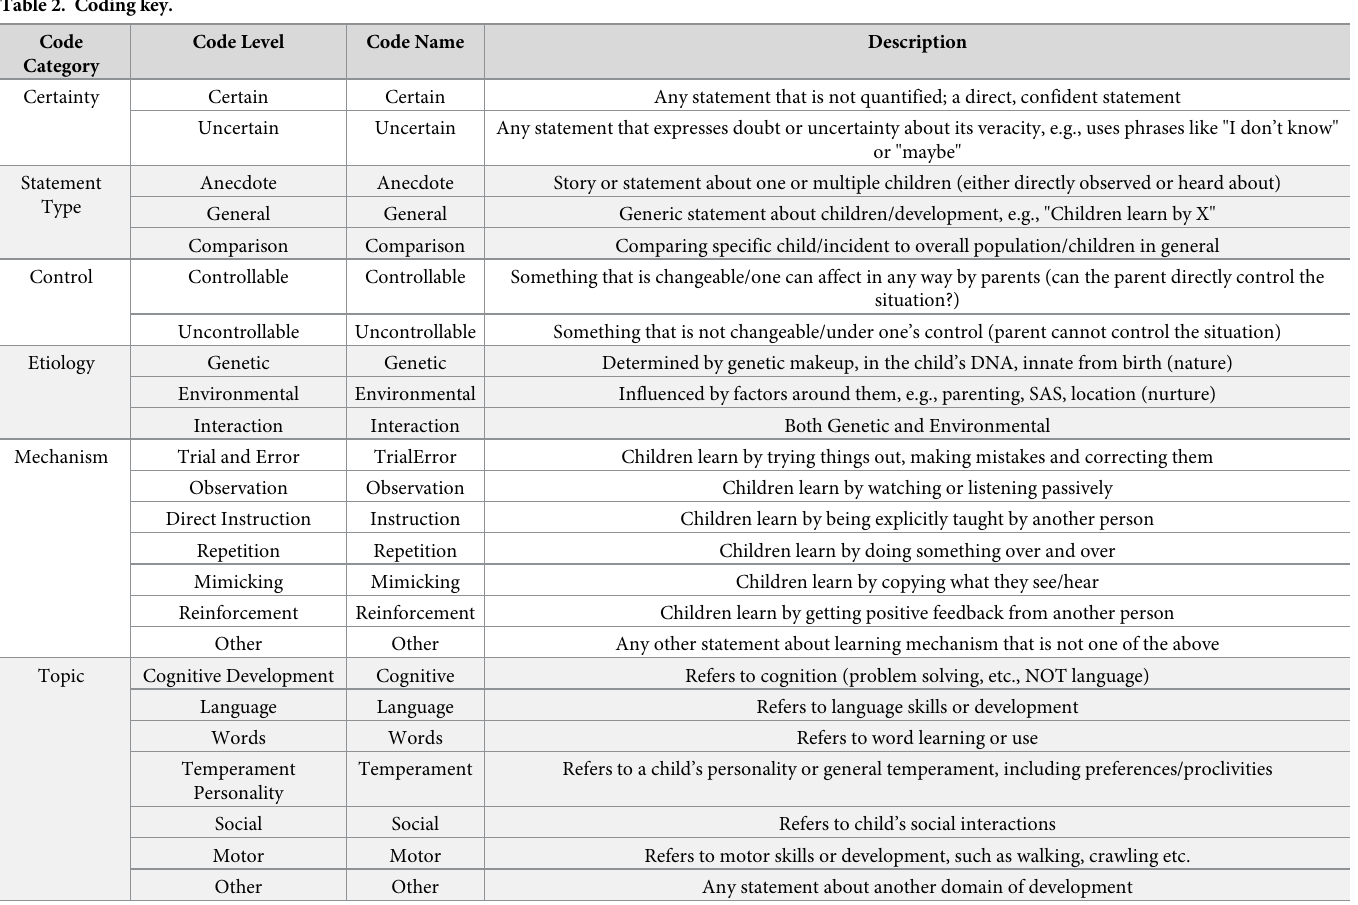
Table 2. Coding key. Code